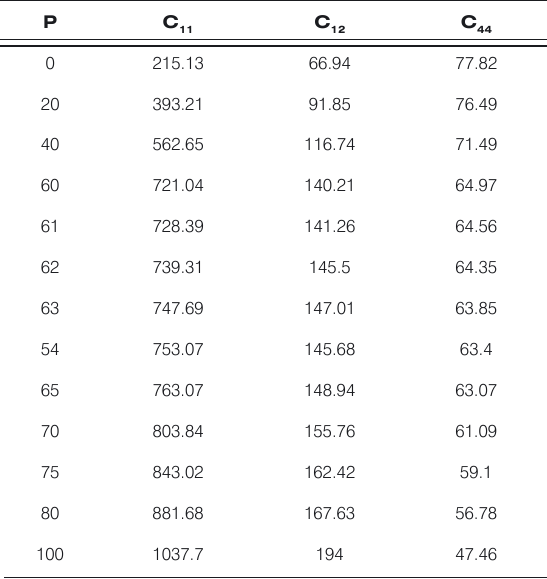
Table 3. Elastic constants at T=300 K of CaO.